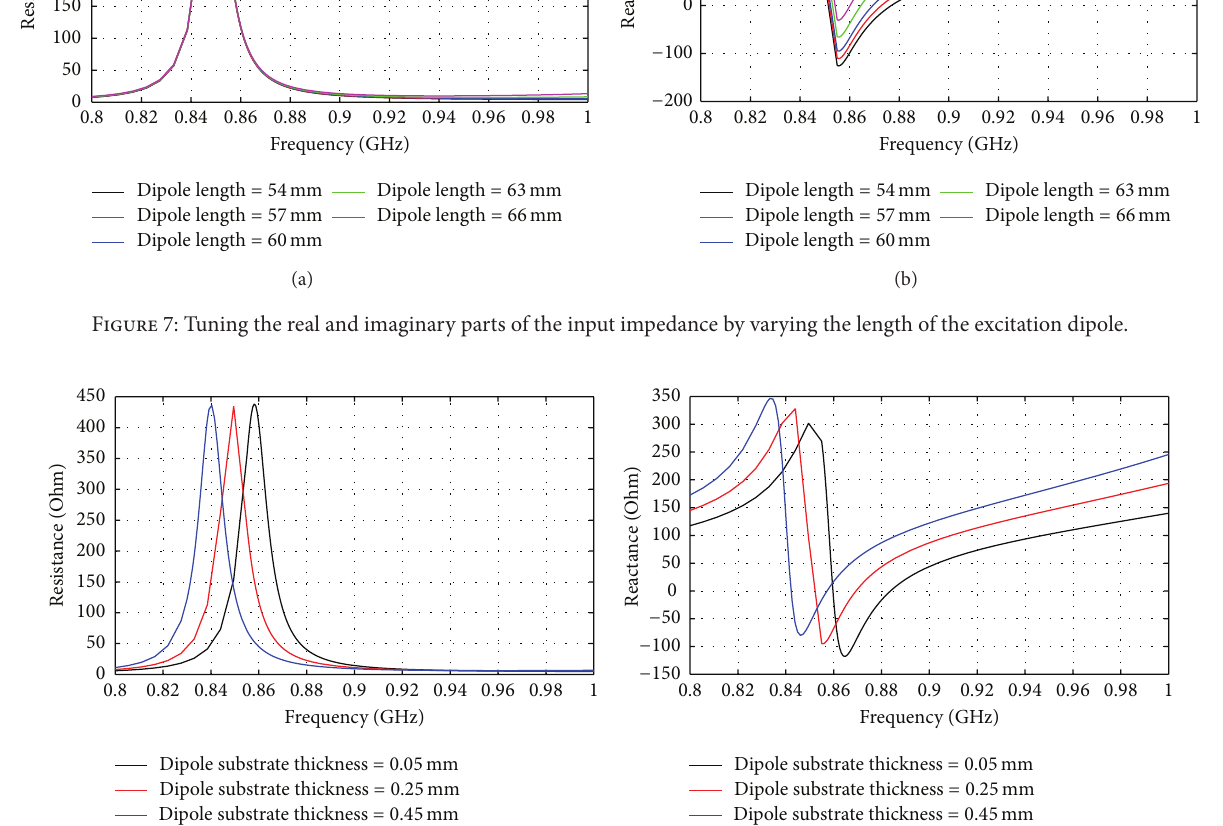
tuning and matching the impedance to the chip impedance using the two types of feeding are described in the following